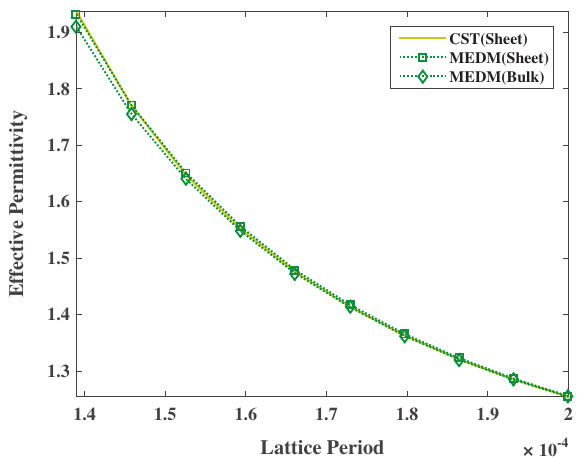
Figure 3. The effect of the finite thickness of the sample on the extracted parameters. The extracted permittivity of two-dimensional arrangement of scatterers (in good agreement for both the CST and proposed scheme) is higher than the bulk permittivity. Full geometric and simulation settings are the same as Figure 2b except for the single layer